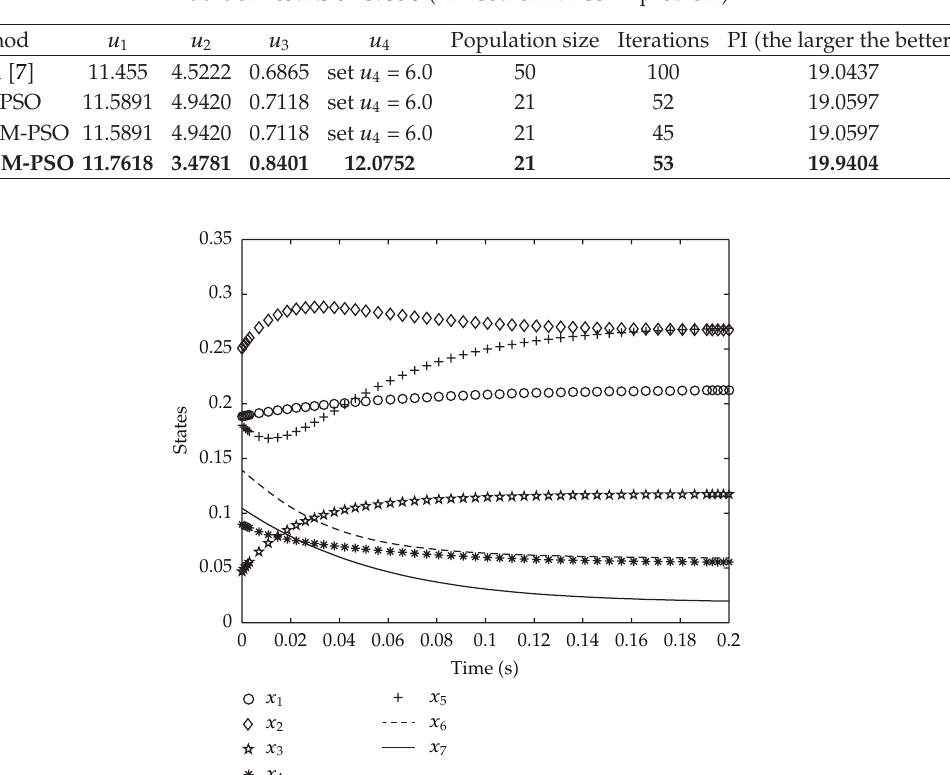
A first-order di ff erential equation is used to find the optimal parameter vector U (cid:8) , u , u , u (cid:7) (cid:6) u 1 2 3 4